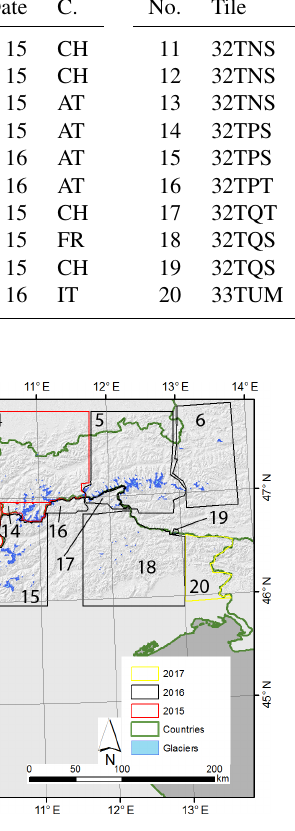
Figure 1. Overview of the study region with footprints (colour- coded for acquisition year) of the Sentinel-2 tiles used (see Table 1 for